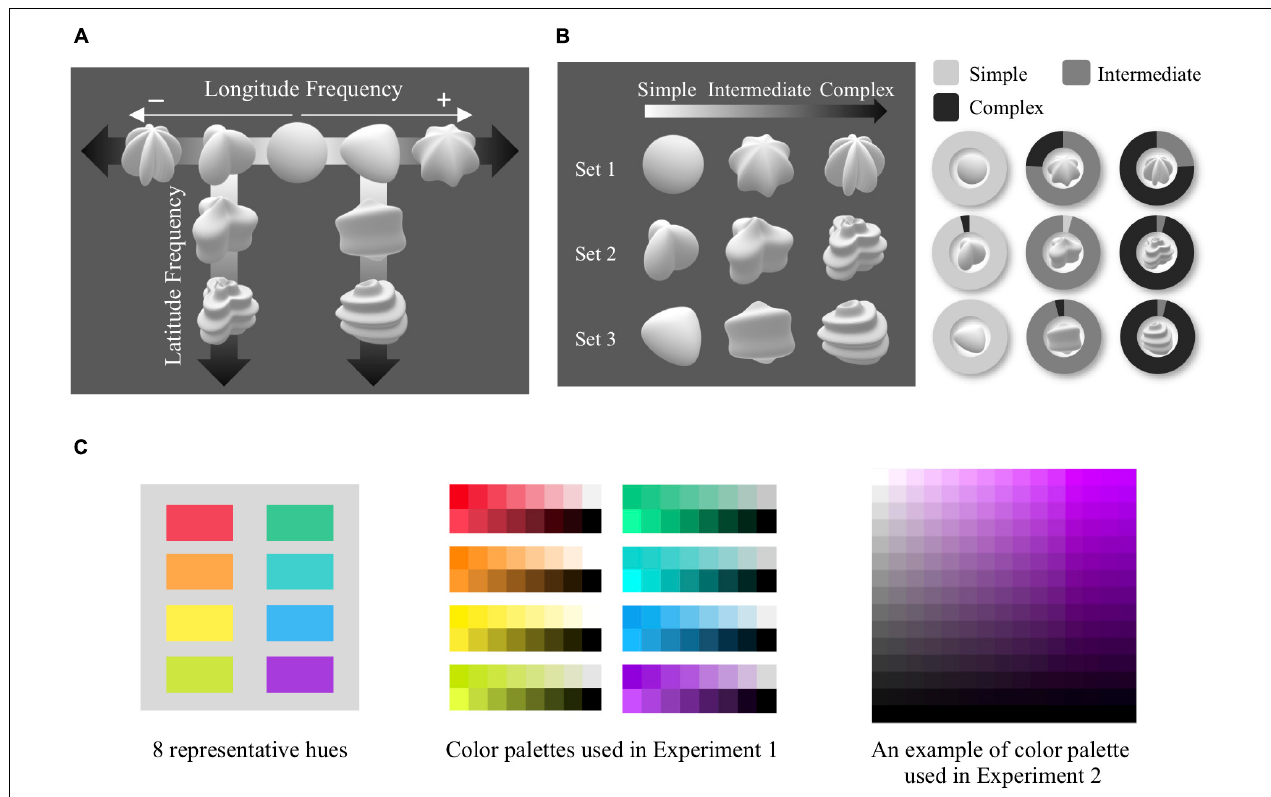
FIGURE 1 | Shape model, conditions, and color palettes. (A) Nine shape models manipulated in complexity were created by modulating longitude and latitude frequencies in Superformula. (B) Three complexity sets used in Experiments 1 and 2 are shown in the left panel. The right panel shows the results of a survey to confirm whether the manipulated complexity levels were in line with the perceived shape complexity. The ratio of each shape ranked as simple/intermediate/complex is shown as the area within the pie chart. (C) Eight representative hues used in experiments are shown in the left panel. From those hues, eight color palettes in the form of brief overview of luminance and saturation were used in Experiment 1 (center panel). An example of the color palette that consists of luminance and saturation dimensions is shown in the right panel, which was used in Experiment 2.